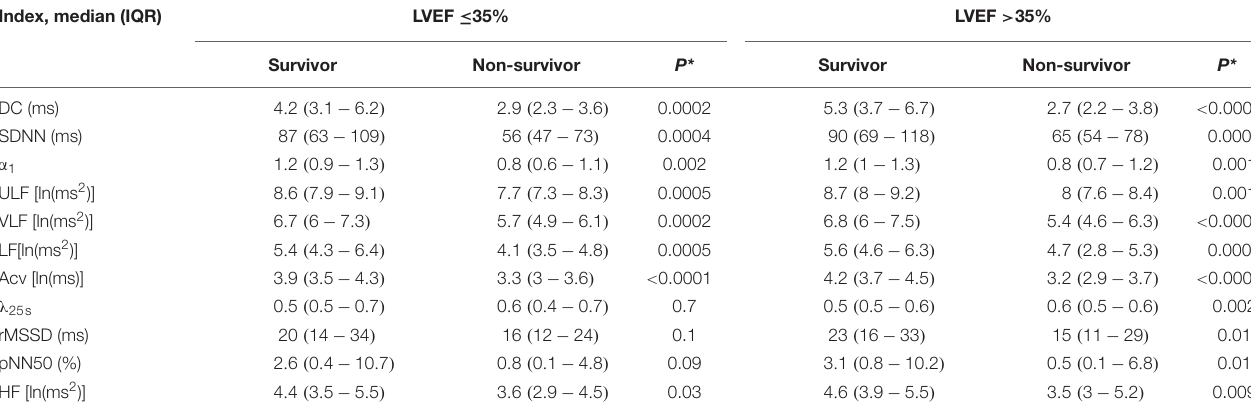
TABLE 2 | Comparisons of baseline heart rate variability (HRV) and heart rate (HR) dynamics indices between survivors and non-survivors. Index, median (IQR)